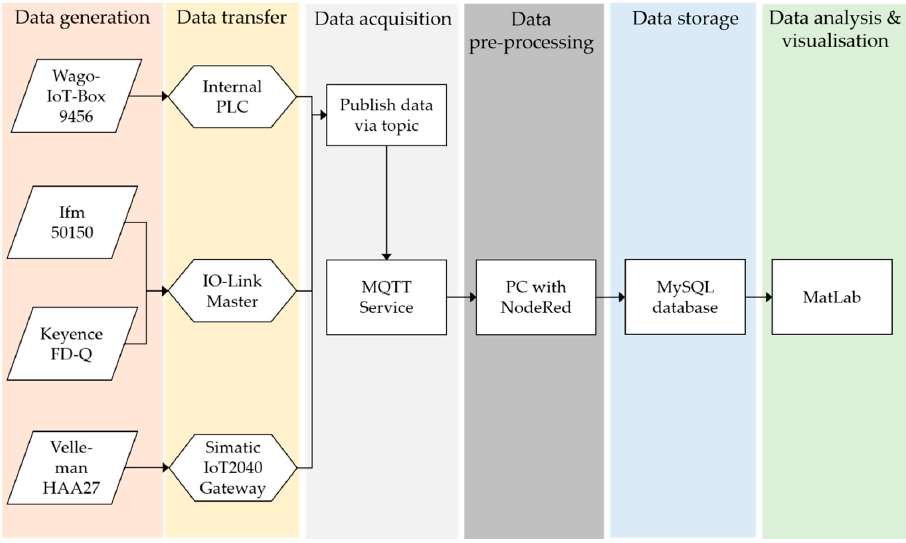
Figure 3. Data handling structure.